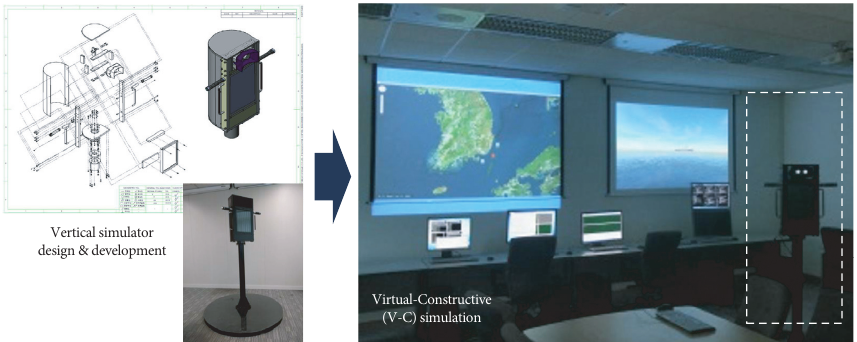
Figure 11: Application of virtual-constructive simulation with periscope